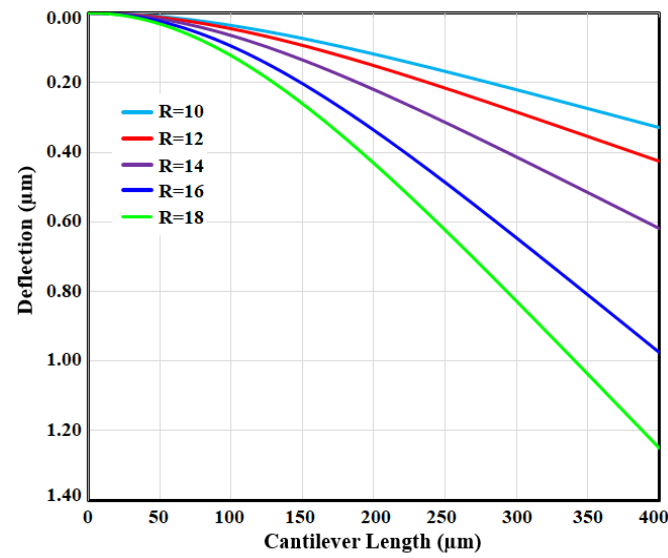
Figure 12. The deflection of MCL1 with L = 400 µm, W = 50 µm, t = 2µm, for different radii of micropore with 400 µm vertical distance from the chip surface. (R is in µm and refer to the diameter of microhole). The air velocity is 5m/s. As the result shows, there is not a linear dependency between the tip deflection of MCL and the microhole radii. According to this diagram, it is possible that the deflection of a microcantilever is controlled by air velocity. Before the testing procedure, calibration could be done with simulation afterward, the AbFM elements be designed.